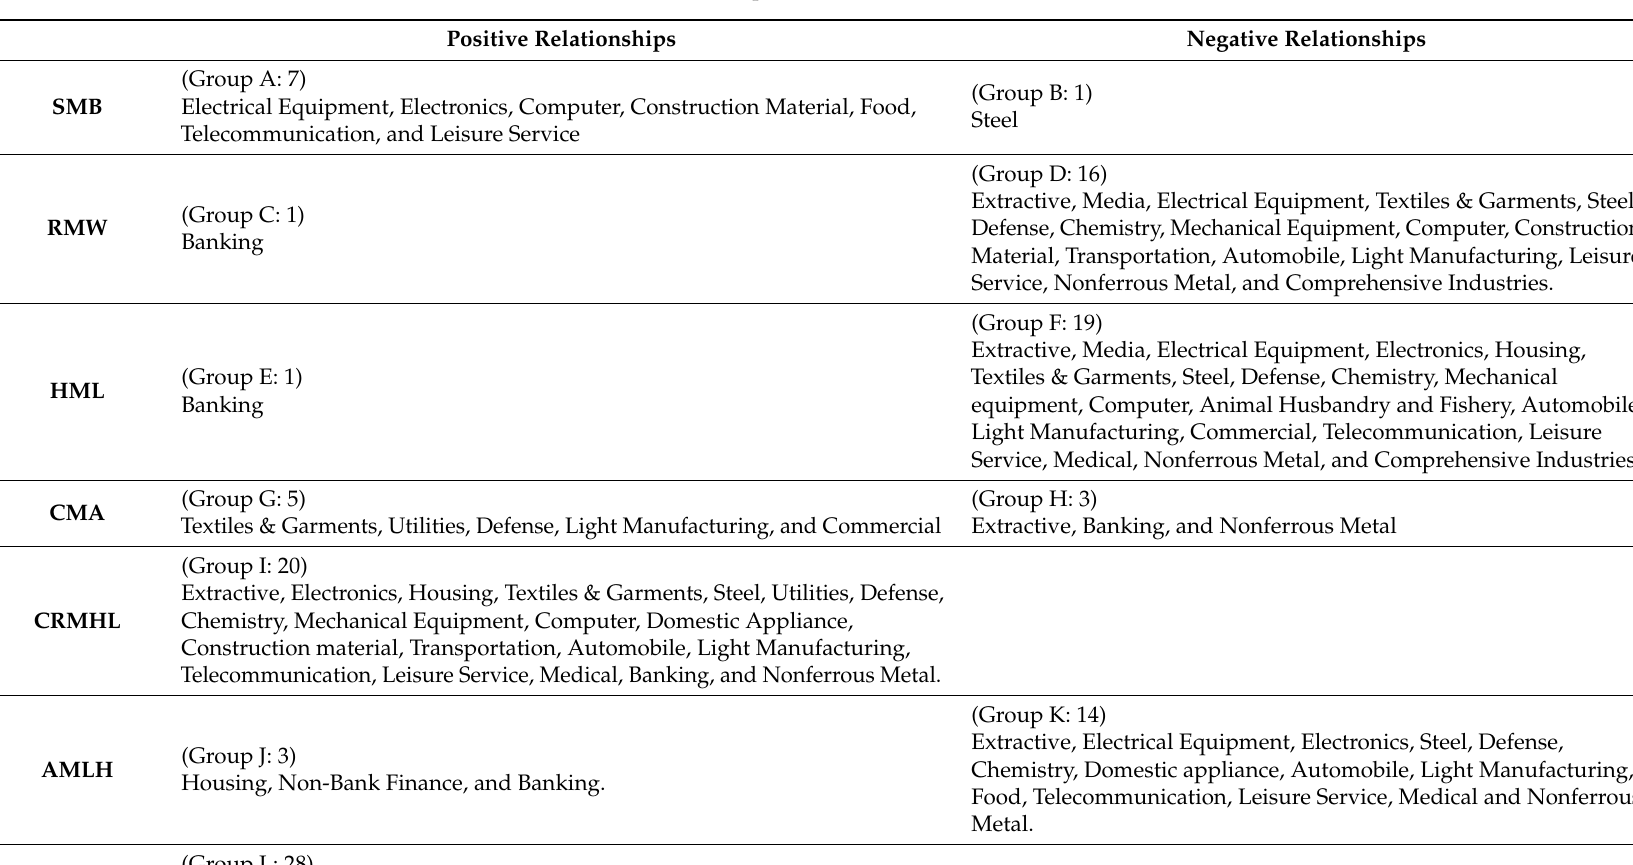
Table 5. Relationships of industries and seven factors. Positive Relationships Negative